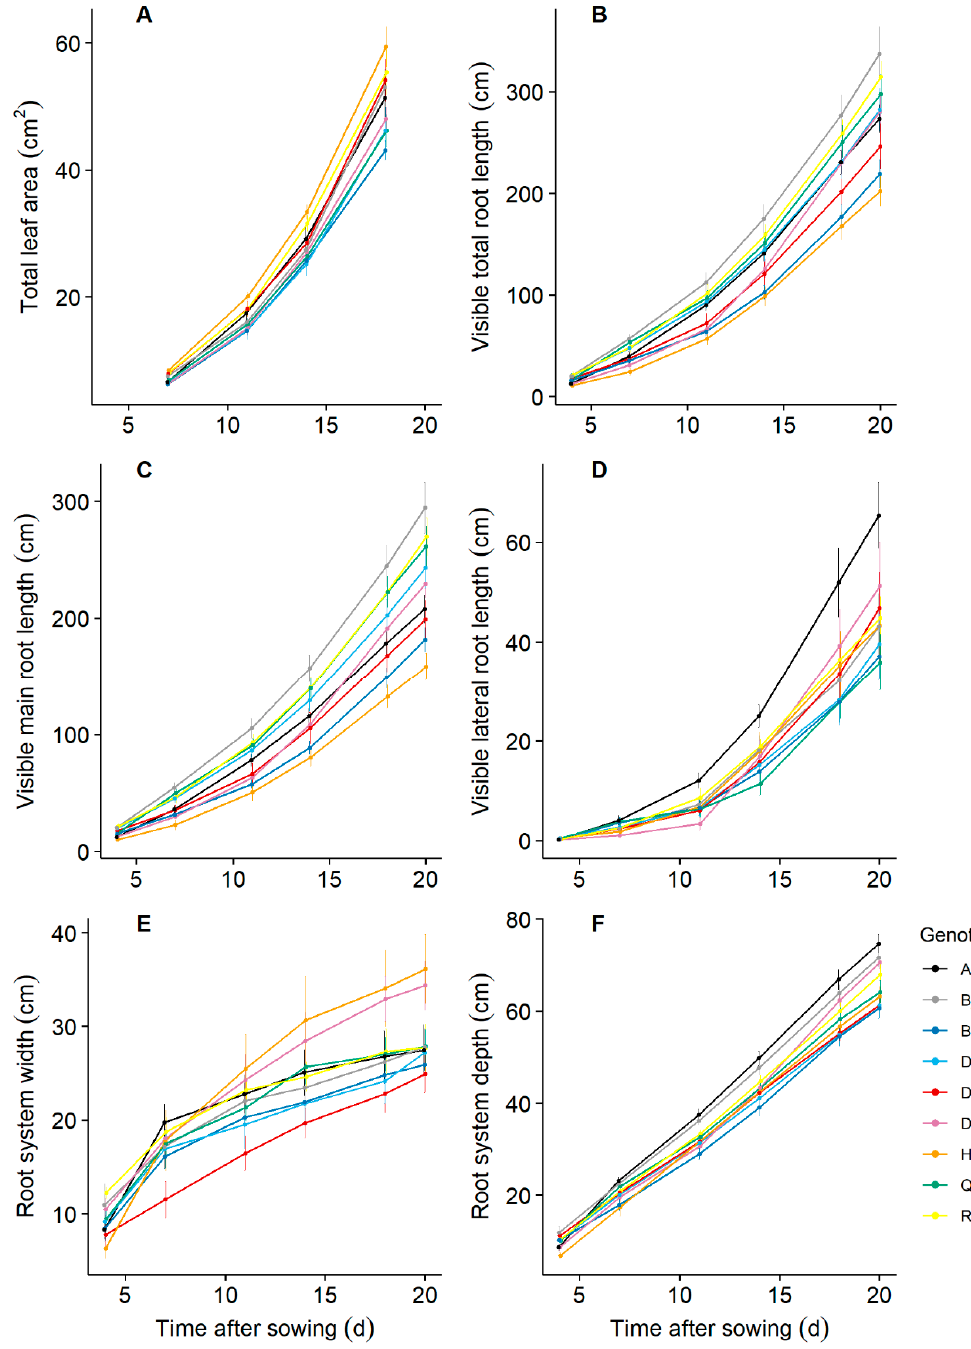
Figure 1. Leaf and root development dynamics along 20 days of growth for nine spring wheat genotypes grown under controlled conditions in a phenotyping facility. The total leaf area was estimated from non-destructive measurements and calculated as leaf length × maximum width × 0.858 [43]. The root parameters were quantified using root images from the automated phenotyping system. Each value represents the mean ± standard error (n = 8).